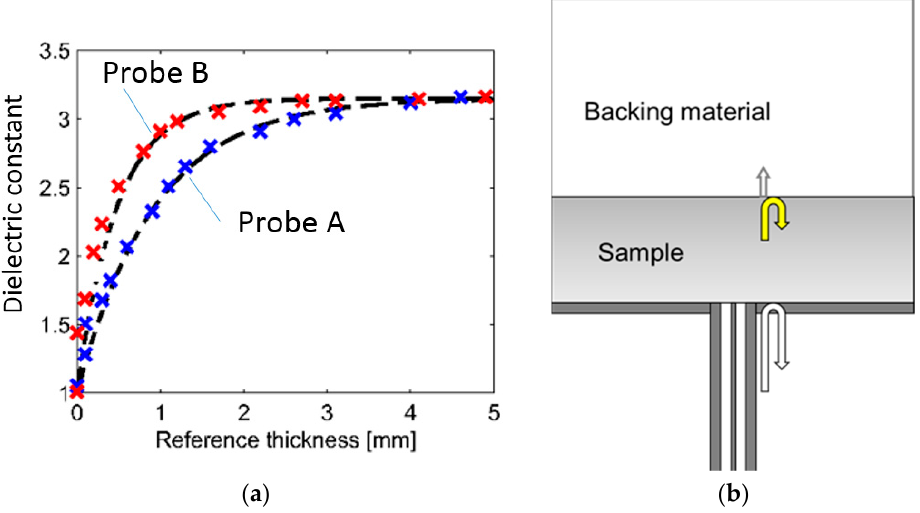
Figure 1. ( a ) Measured effective dielectric constant of an ice layer backed by air as a function of layer thickness. The diameter of Probe B is smaller than that of probe A. ( b ) Illustration of measurement problem: The permittivity of a sample of finite thickness backed by a backing material is measured using an on open-ended coaxial probe.